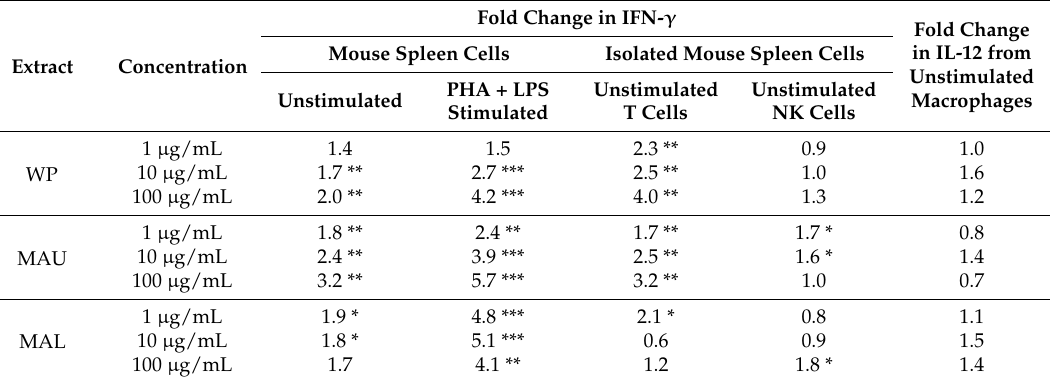
Table 1. Effect of different concentrations of EJ extracts on IFN- γ production from unstimulated, phytohemagglutinin (PHA) + LPS stimulated mouse spleen cells, unstimulated T cells and NK cells and IL-12 production from unstimulated macrophages.